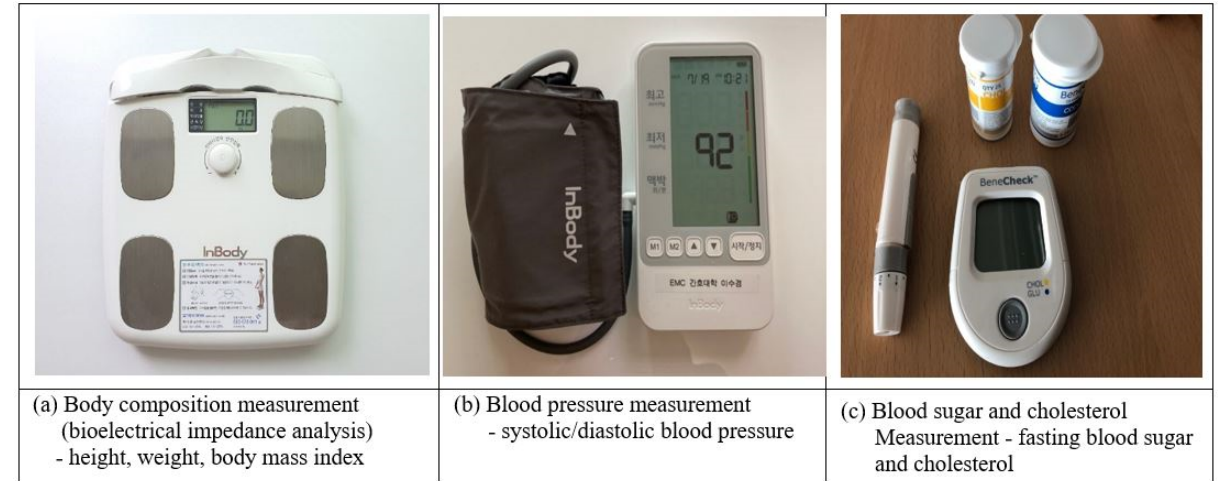
Figure 2. Physical and physiological assessment